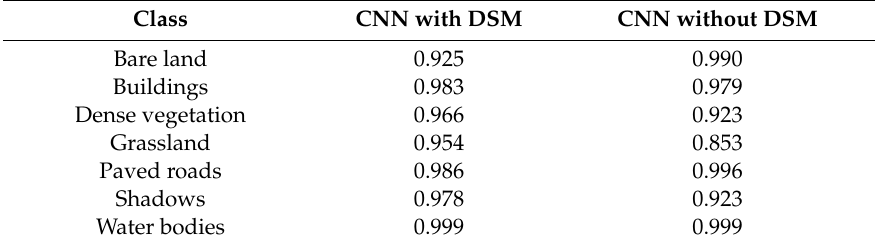
Table 4. PA obtained by the di ff erent classification methods for the testing dataset.